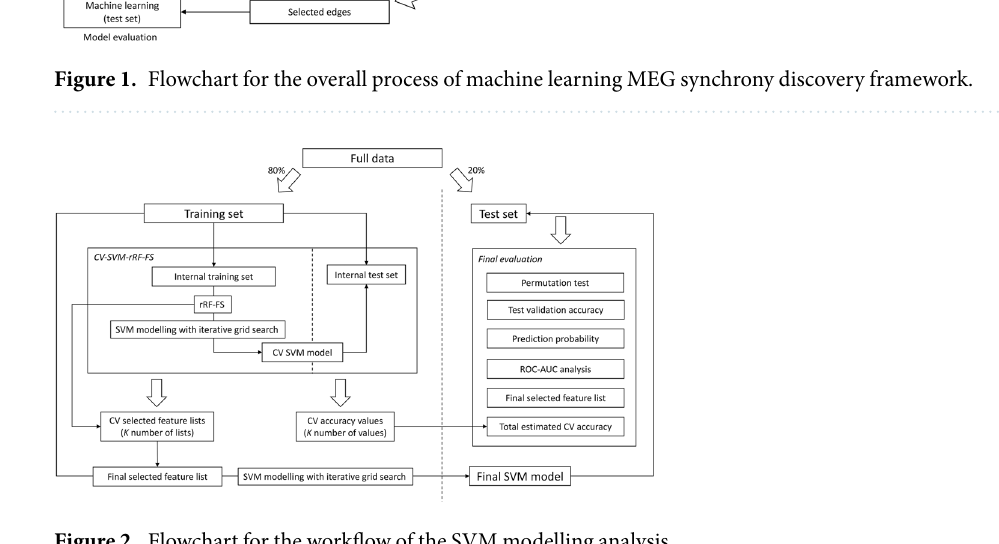
Figure 2. Flowchart for the workflow of the SVM modelling